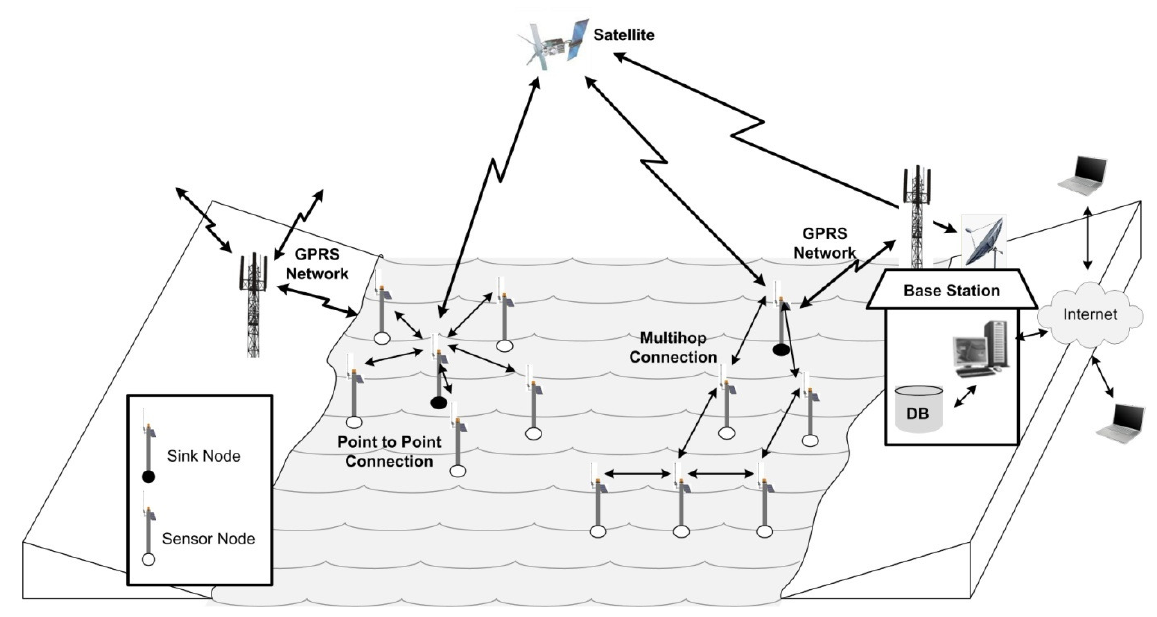
Figure 2. General structure of an A-WSN for oceanographic